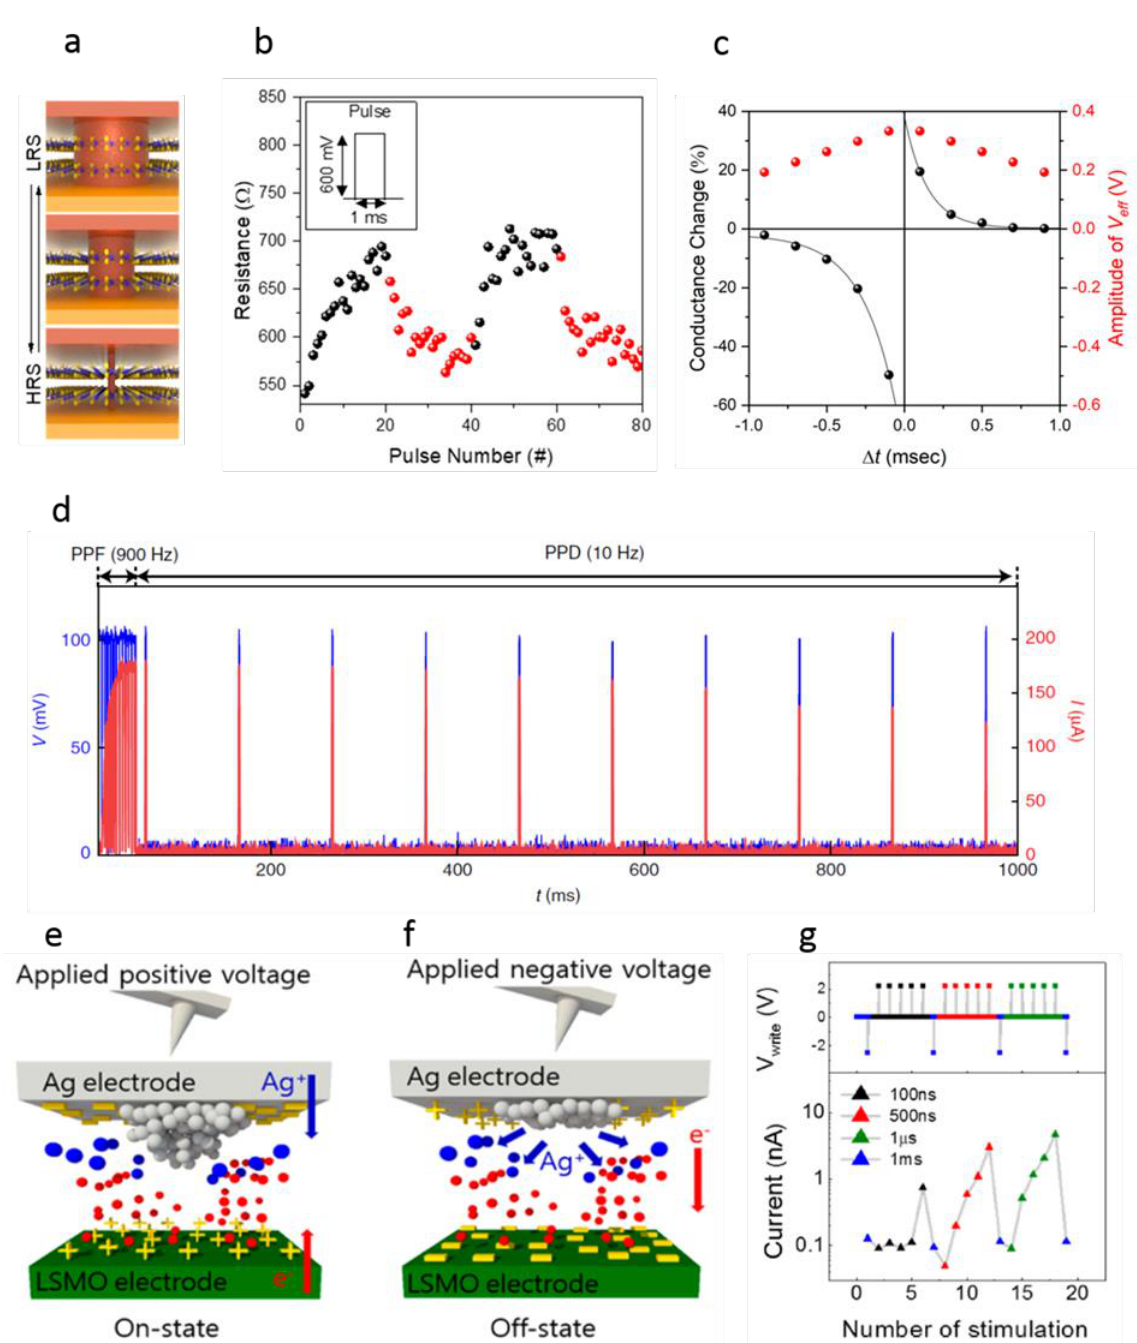
Figure 4. ( a ) Schematic of the change in the cation – movement – based filament for the Cu/MoS 2 double-layer/Au with switching between HRS and LRS. ( b ) Potentiation – depression curve obtained by consecutive pulses with a small amplitude of 0.6 V and ( c ) STDP behaviors obtained by low – amplitude spiking for the Cu/MoS 2 double – layer/Au. Reprinted/adapted with permission from Reference [31]. 2019, American Chemical Society. ( d ) The current response of frequency – dependent PPF and PPD obtained by input pulses (100 mV, 1 ms) in a cation – movement – based filamentary two – terminal synaptic device with protein nanowires. Reprinted/adapted with permission from Reference [32]. 2020, Springer Nature. ( e , f ) Schematic illustrations of growth and rupture of an uncompleted CF of Ag in an Ag/PZT/LSMO device in LRS and HRS, respectively. ( g ) Potentiation behaviors obtained by stimulation pulses with different durations for an Ag/PZT/LSMO device. Reprinted/adapted with permission from Reference [33]. 2017, American Chemical Society.